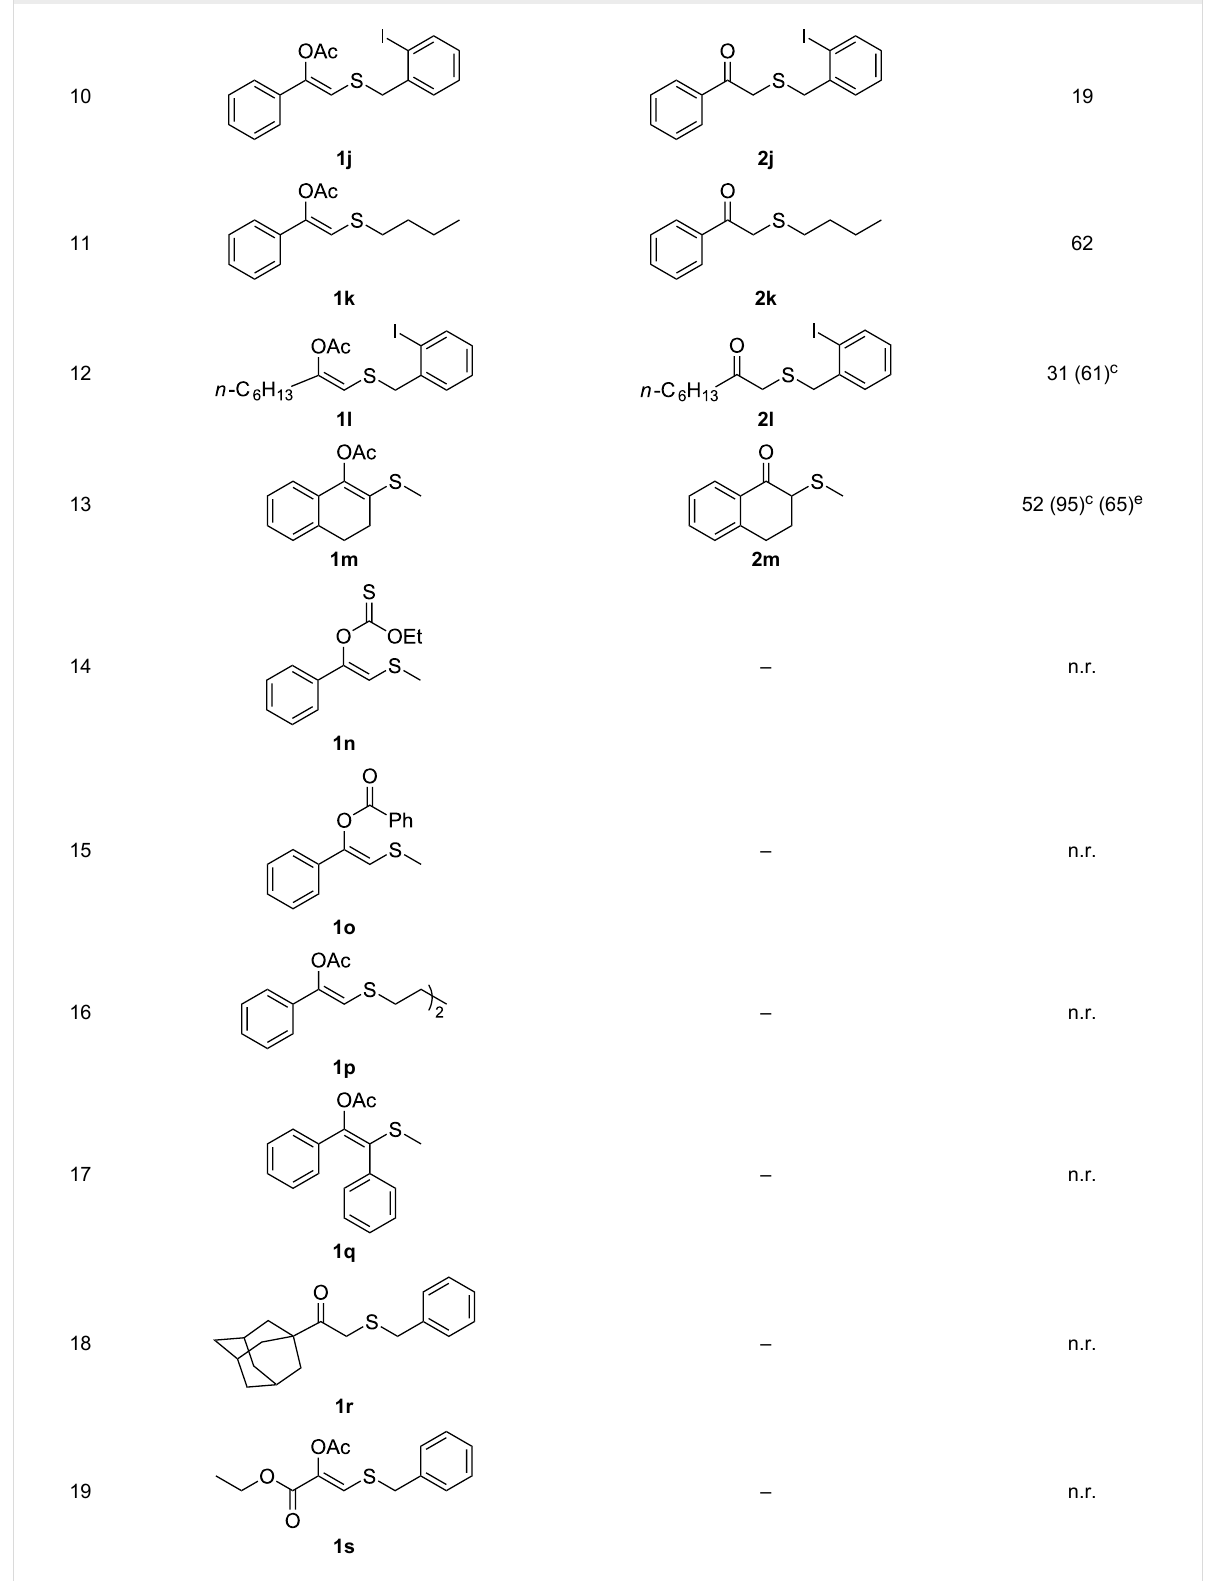
Table 2: Lipase-catalysed hydrolysis–protonation sequence over a series of β -thioalkyl enol esters. a